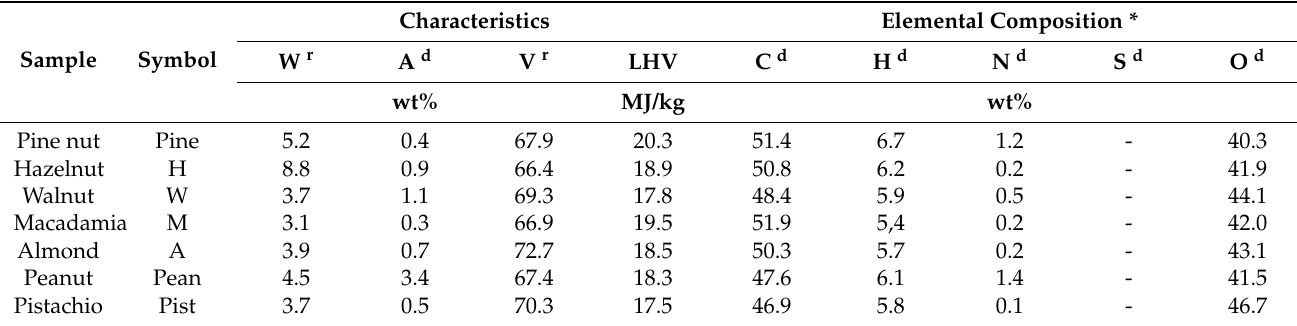
Table 1. Physicochemical characteristics of the nut shell samples.